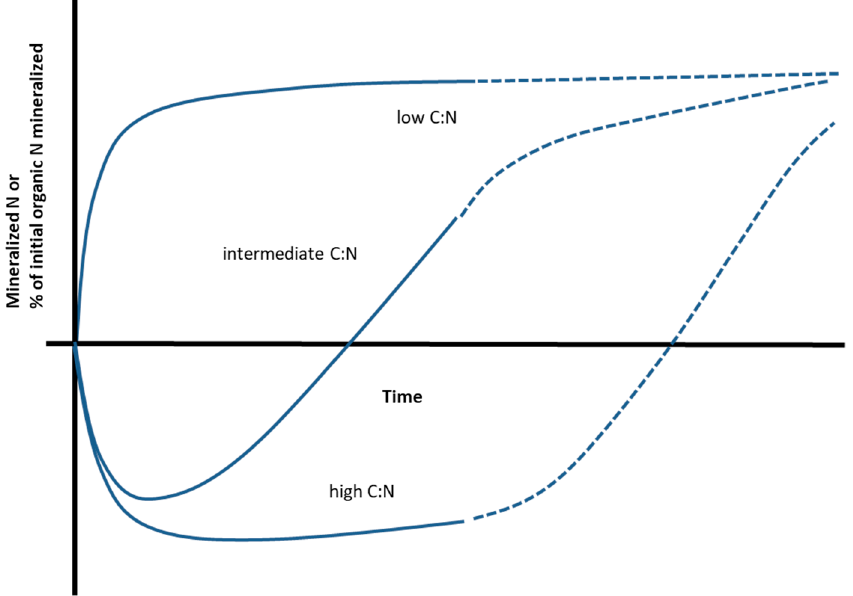
Figure 1. Alternative dynamics of soil inorganic N after the addition of organic residues (modified from [3]).